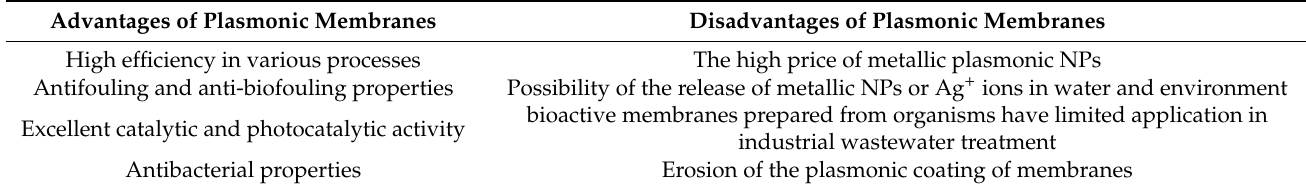
Table 1. Some of the important advantages and disadvantages of plasmonic